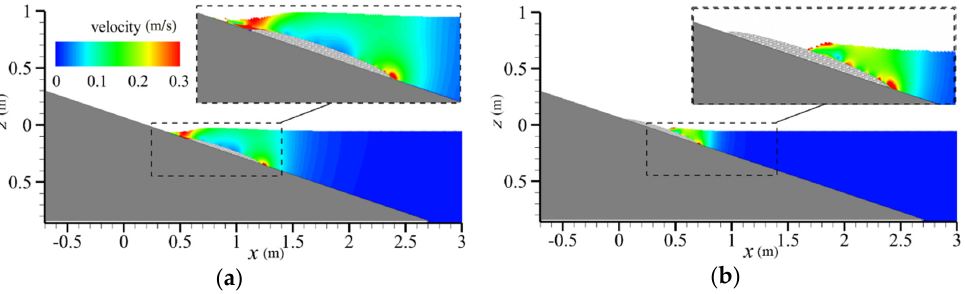
Figure 3. The velocity cloud diagram at t = 0.75 s and t = 0.97 s: ( a ) t = 0.97 s; and ( b ) t = 0.75 s.